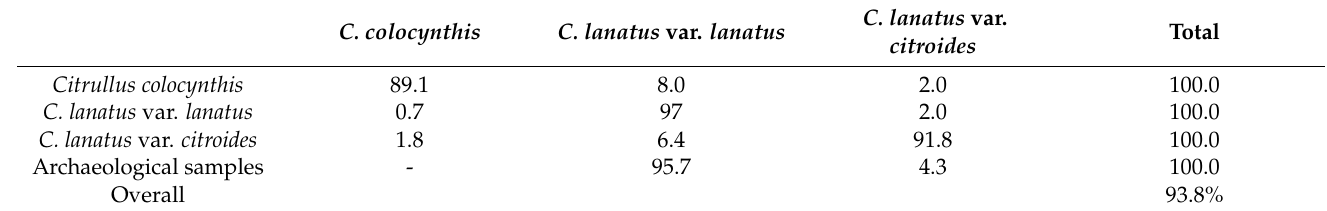
Table 2. LDA percentage results of comparison among modern seeds of Citrullus colocynthis , C. lanatus var. lanatus , and C. lanatus var. citroides and Middle Ages watermelon seeds considered as unknown.